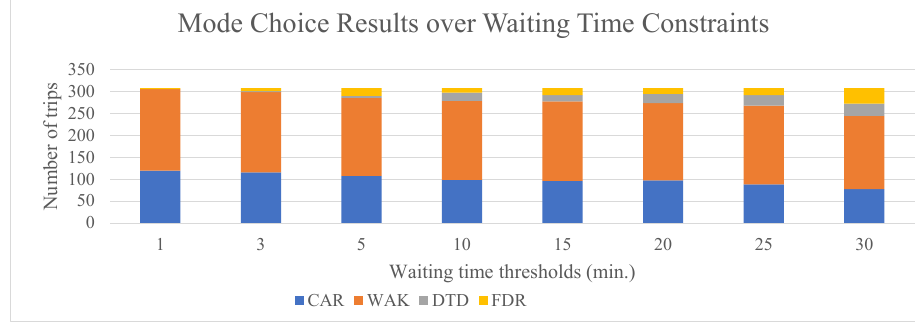
Figure 5. Mode choice results over waiting time constraints.